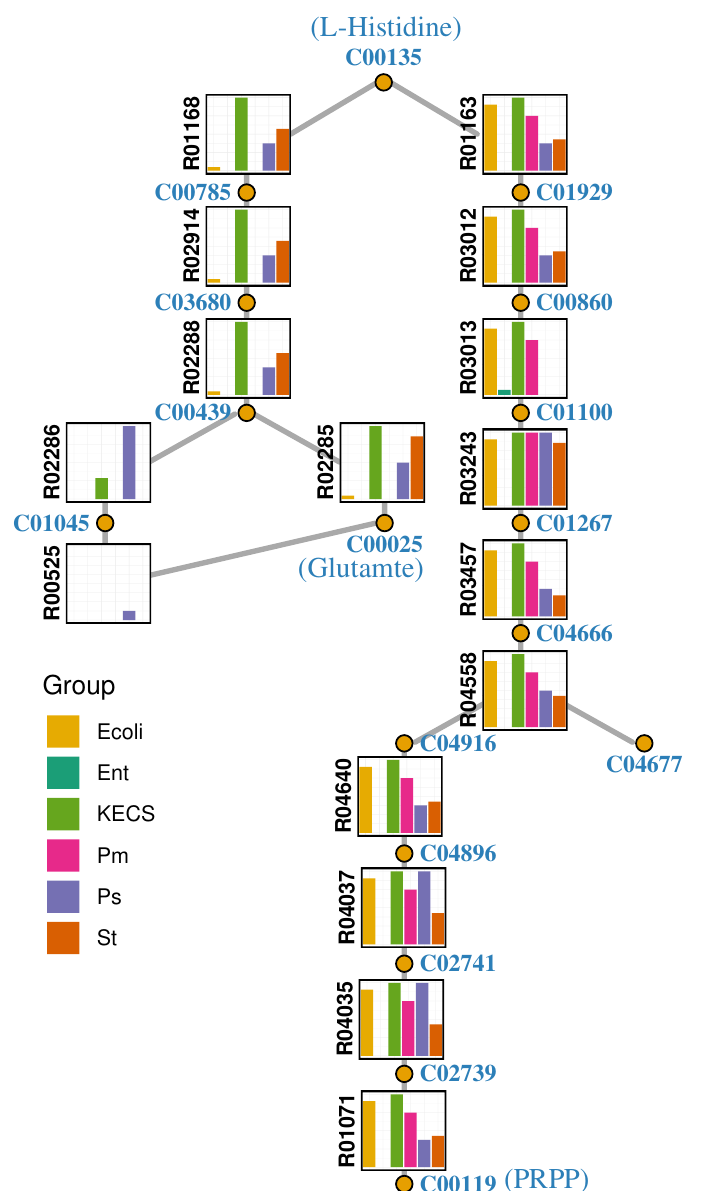
Figure 4. Network representation of histidine metabolism adapted from the corresponding KEGG histidine metabolism pathway (map00340). Circles correspond to compounds and bar plots to reactions. The percentage of species belong to each genera that possess the KEGG Ortholog associated with each reaction is represented by the size of the bar, coloured according to taxonomy inside the bar plot. In this example, coherently with the high complementarity value of enterococci, all the genera share a pathway towards biosynthesis of histidine, except for enterococci. C00119 is equivalent to 5-Phospho-alpha-D-ribose 1-diphosphate (PRPP). C04677 is equivalent to 5’-Phosphoribosyl-5- amino-4-imidazolecarboxamide